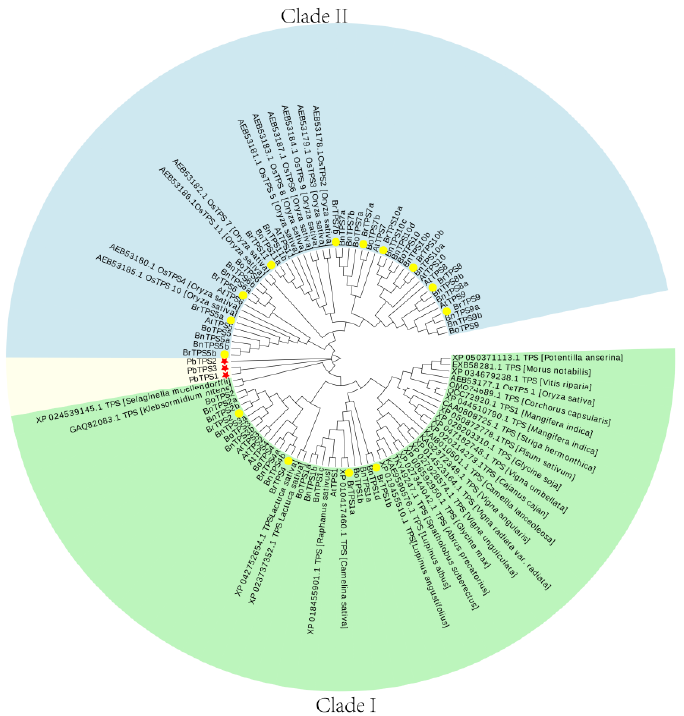
Figure 2. Phylogenetic relationship of Br TPS and PbTPS . All TPS proteins were divided into three subgroups, represented by three colors. The green color represents Class I proteins, the blue color represents Class II proteins. The yellow circle symbol represents the BrTPS proteins. The unrooted phylogenetic tree was constructed using the neighbor-joining (NJ) method with 1000 bootstrap replications by MEGA6